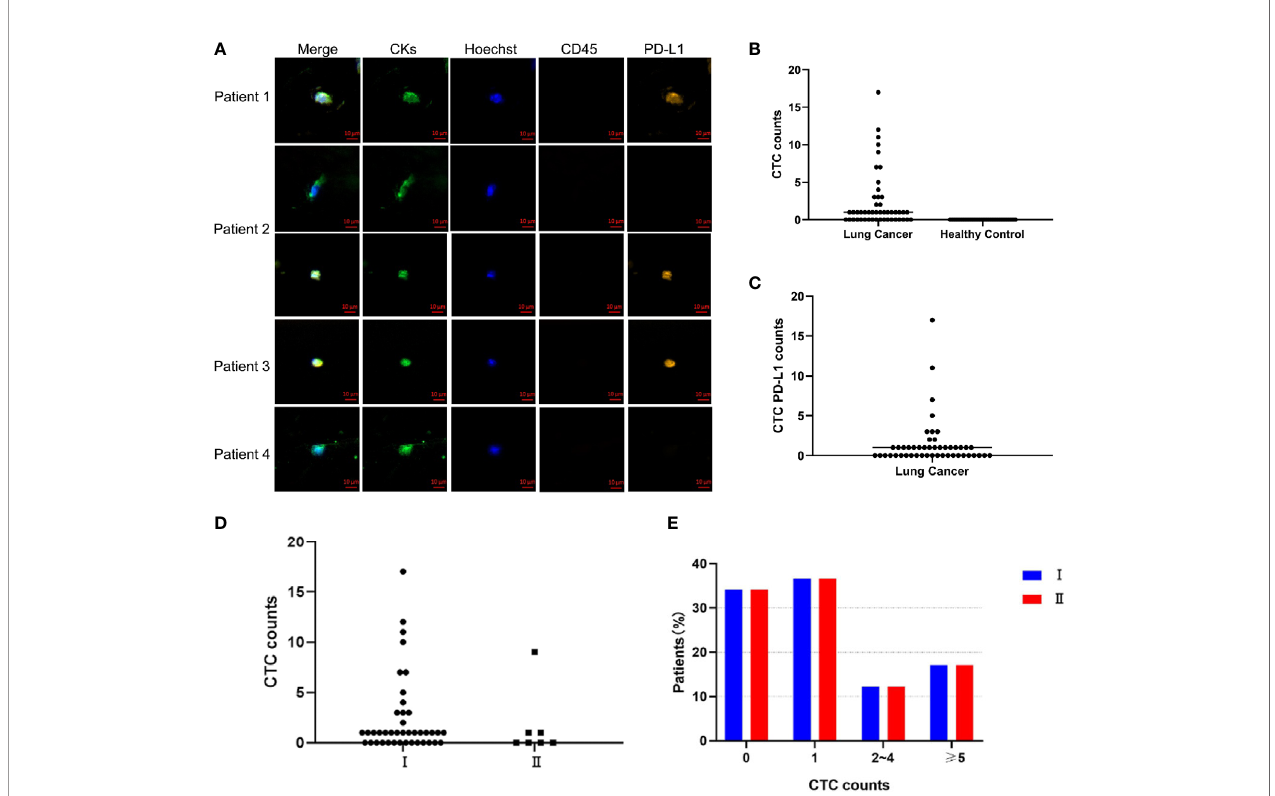
FIGURE 1 | CellCollector captures representative CTC graphs and CTC and CTC PD-L1 detection. (A) CellCollector captures CTC identi fi cation charts. Patient 1 captures 7 CTCs, patient 2 captures 3 CTCs, patients 3 and 4 capture 1 CTC. (B) Detection rate and number of CTC in lung cancer patients and healthy controls. (C) Detection rate of PD-L1+ CTC in patients with lung cancer. (D) Detection rate and number of CTC in stage I and stage II lung cancer patients. (E) Distribution of detected CTCs in stage I and stage II